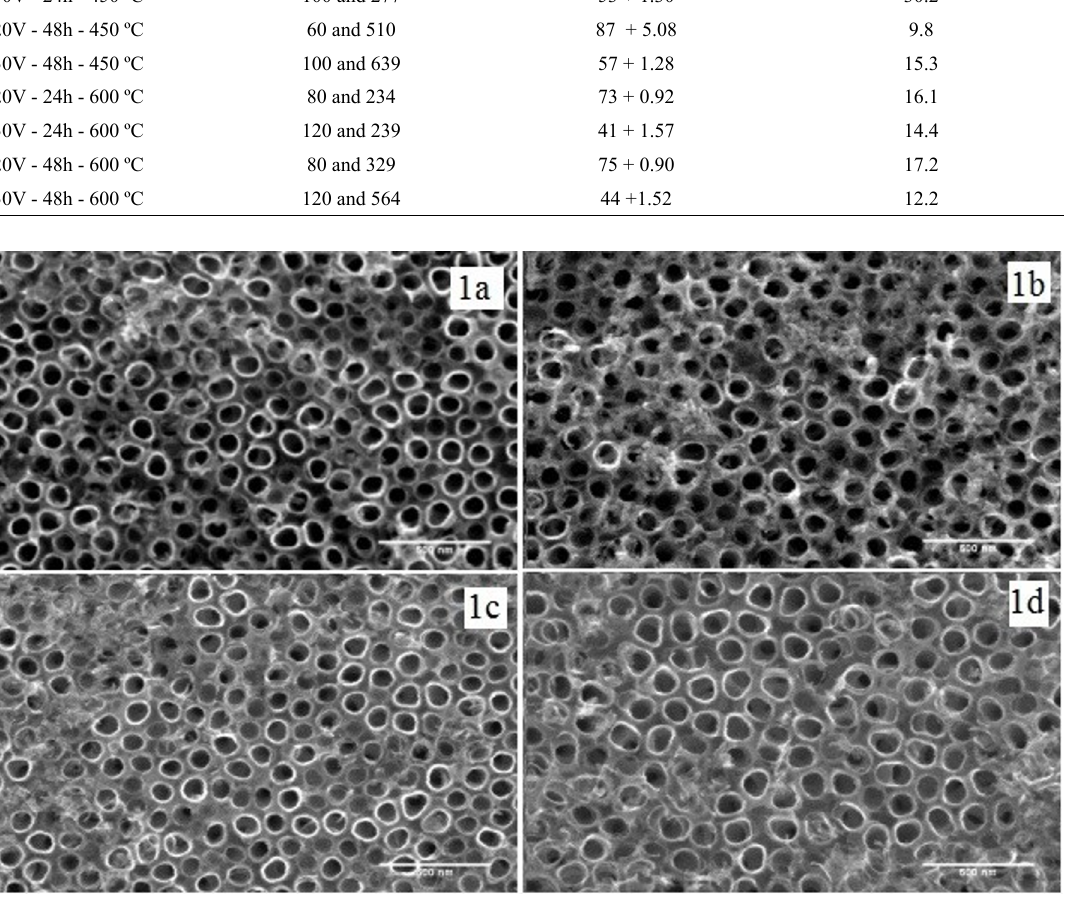
Figure 1. SEM micrographs of the Ti-7.5Mo alloy after anodization at 20V and 30V for 24 hours and 48 hours, calcined at 450 ºC: samples anodized at 20 V (1a and 1c) and 30 V (1b and 1d) 48 hours (Figure 2d), respectively. According Macak et al . (2008) 32 , the diameter changes linearly with the potential applied during the growth of nanotubes and it was observed in our